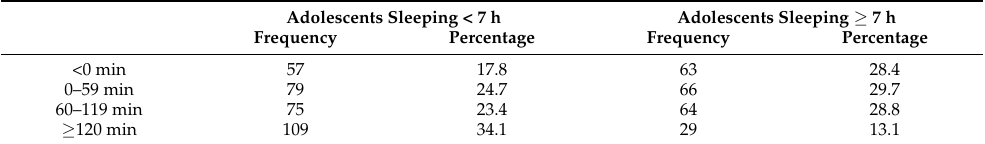
Table 4. Distribution of participants sleeping < 7 h or ≥ 7 h among the categories based on the duration of weekend catch-up sleep. Frequency and percentage are